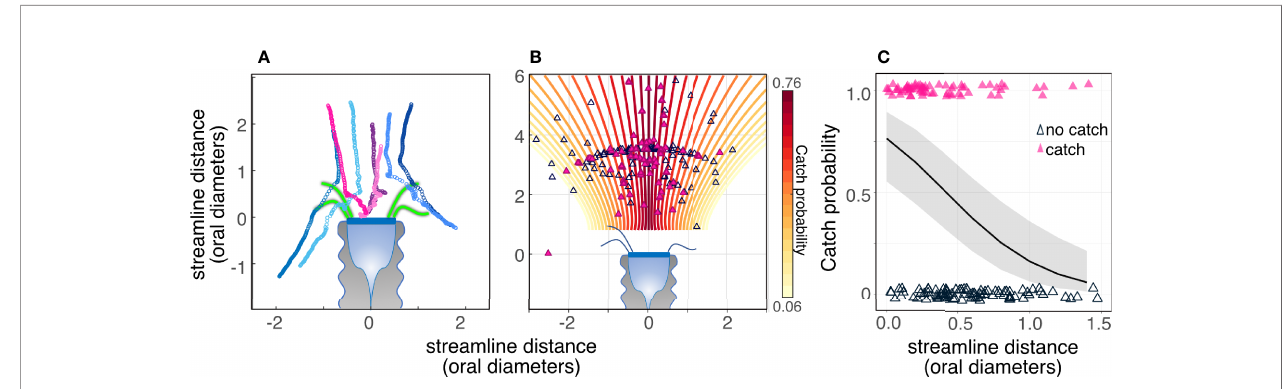
FIGURE 5 | Particles encountered the tintinnids ’ polykinetids and oral area if they traveled along the streamlines demarked by the edges of the polykinetids; however, not all encountered particles were captured. (A) Tracks of encountered particles showing captured (warm colored-symbols) and non-captured (cold colors) particles. Consecutive symbols represent the location of the prey at 1.25 ms intervals. Representative polykinetids are drawn in green and are to scale. (B, C) Catch probability decreased signi fi cantly with increasing distance from the central streamline. Closed (pink) triangles denote captured particles while open triangles denote particles that were not captured. The color of the streamlines in (B) and the slope of the black line in (C) denote the expected change in capture probability with streamline distance (logit function) based on a GLM model ( SEM Table 6 ). Gray area in (C) is the con fi dence interval of the logit function. Data are for Climacocilys scalaria